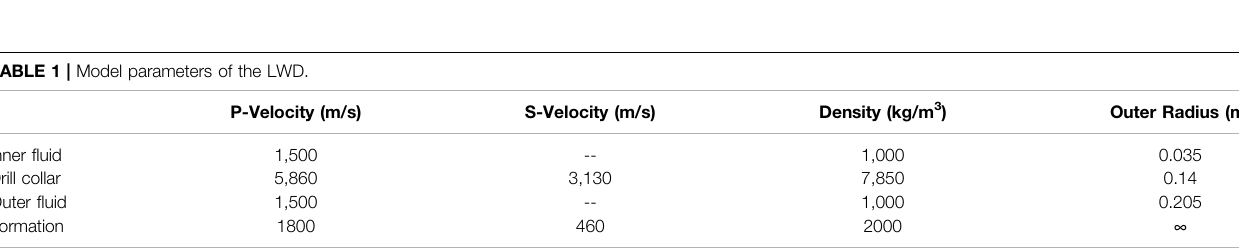
TABLE 1 | Model parameters of the